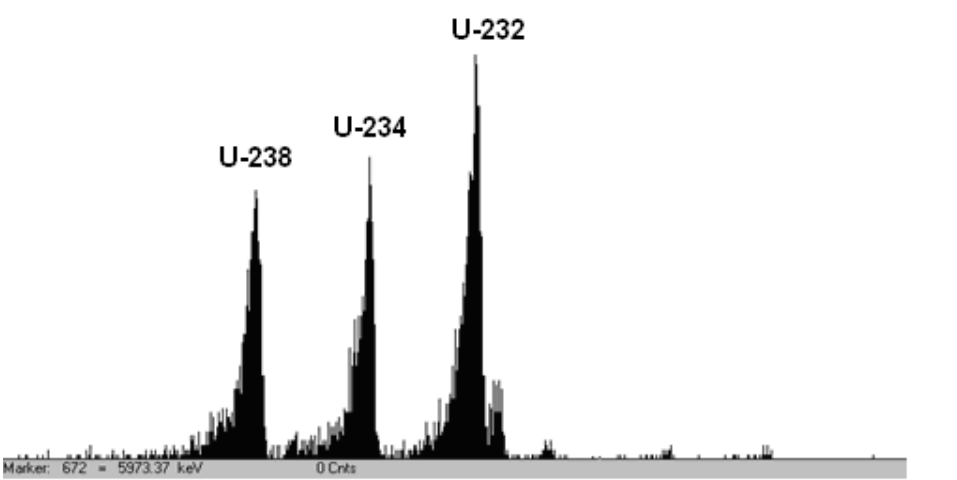
FIGURE 2. Alpha spectrum of U fraction after separation soil